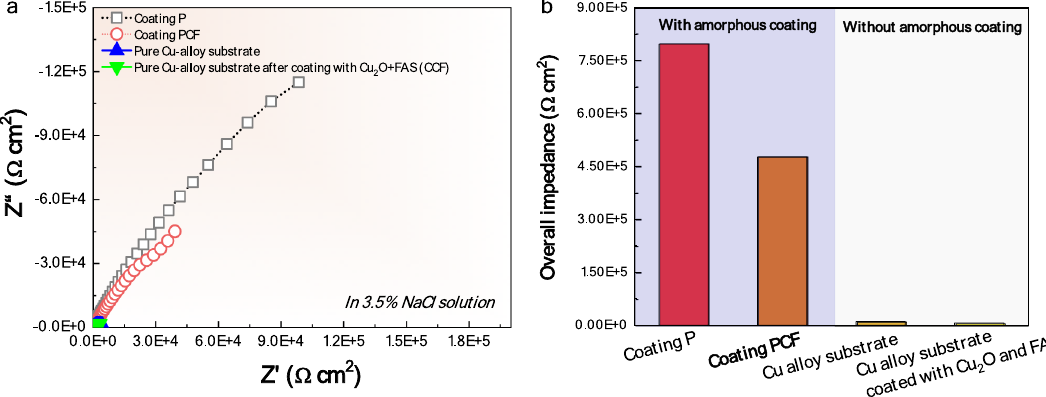
Figure 8. Corrosion resistance of the coatings in a 3.5% NaCl solution. ( a ) Nyquist plots of the coating PCF, compared with the unmodified coating P, pure CuAl alloy substrate. ( b ) Comparison of the overall impedance of the four samples, highlighting the importance of the Fe-based amorphous coating in enhancing the corrosion